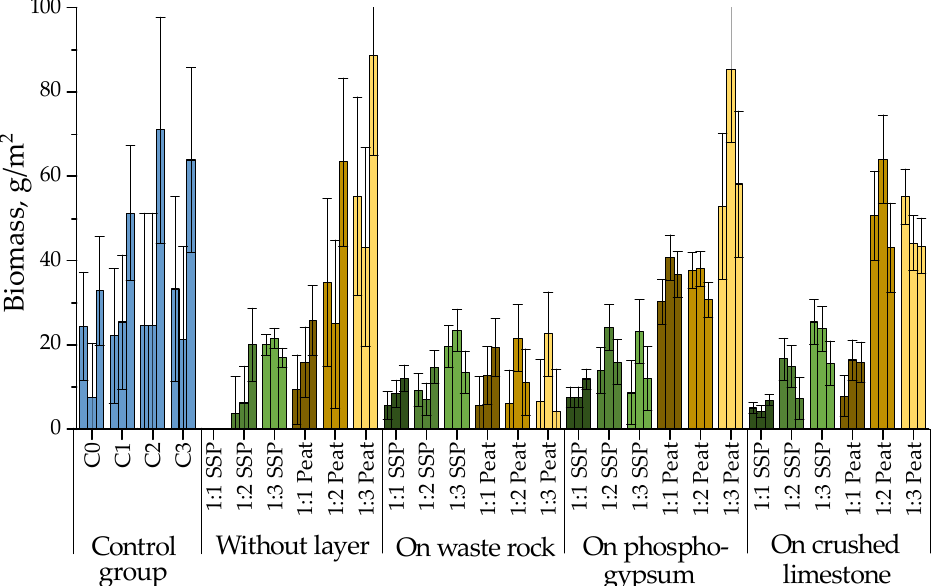
Figure 6. Diagram of the biomass by the weight of plant material cuts (g/m 2 ): A group of models: A—without layer, B—on waste rock, C—on phosphogypsum, D—on crushed limestone; with six types of wastewater sludge and peat mixture (SPP, peat) and ratios (1:1, 1:2, 1:3); with 3-time measurements. The data represent the mean of 4 replicates; the vertical bars indicate standard deviations.